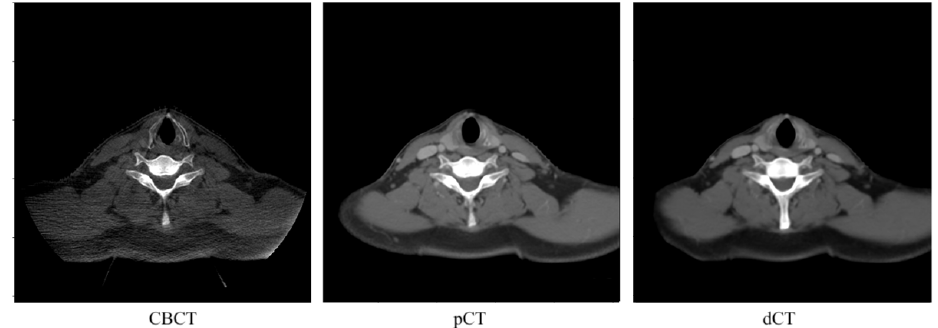
Figure 1. Examples of CBCT, pCT, and dCT images of the same